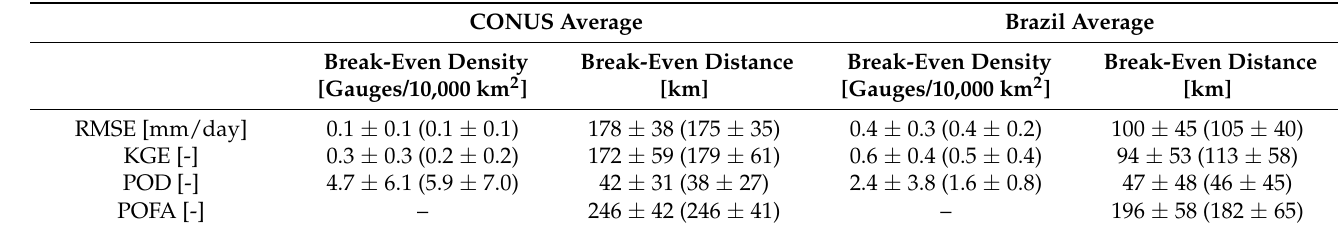
Figure 5. Break points for gauge densities at which IMERG-Early and Late can be expected to perform similarly to interpolated gauge data in terms of ( a ) RMSE, ( b ) POD, ( c ) KGE, and ( d ) POFA. Table 1. The average and ± standard deviation of break-even points in CONUS and Brazil study areas in terms of both gauge density and distance to nearest available gauge. IMERG-Early breakpoints are shown out of parentheses and IMERG-Late breakpoints are in parentheses. Brazil